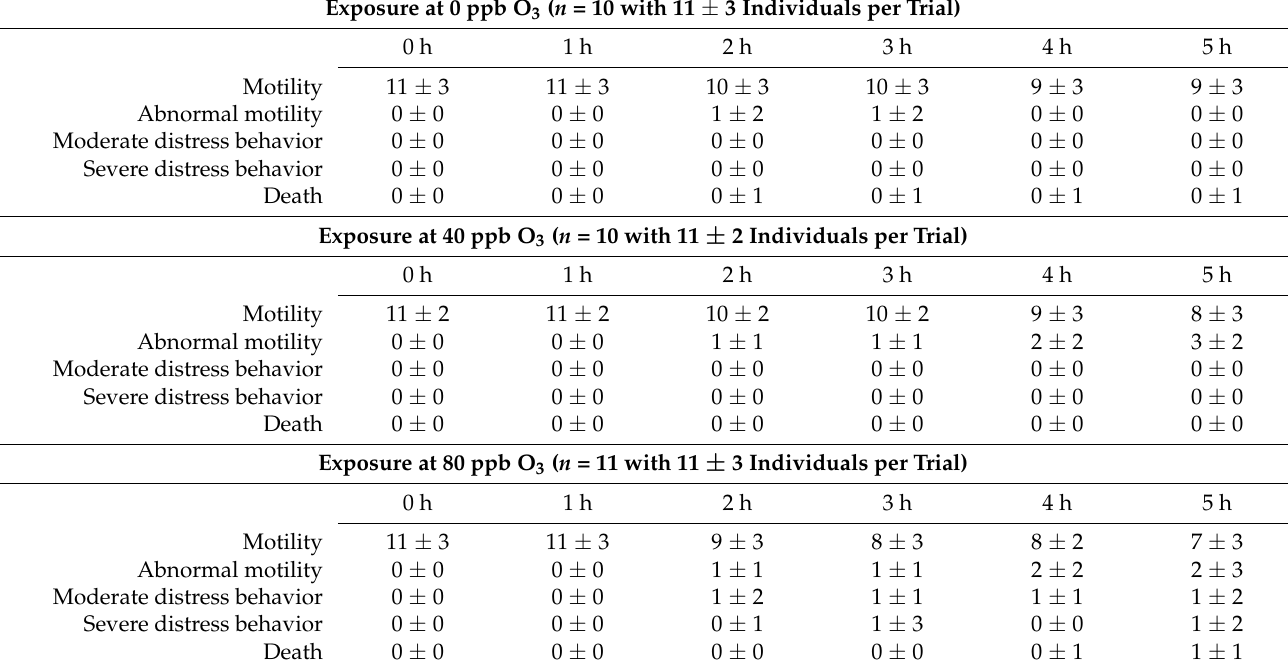
Table A1. Behavior of fig wasps exposed to O 3 regimes for one hour (0, 40, 80, 120, and 200 ppb). After O 3 exposure, individuals were left in climate-controlled conditions and monitored hourly for 5 h to track survival and record behavioral responses. Five distinct behaviors were observed: (1) motility, (2) abnormal motility, (3) moderate distress behavior (i.e., individuals alternately lying on their backs or upright), (4) severe distress behavior (i.e., individuals lying on their backs, unable to right themselves), and (5) death. Data are expressed as the number of individuals displaying the different behaviors (mean ± sd), per O 3 regime and over